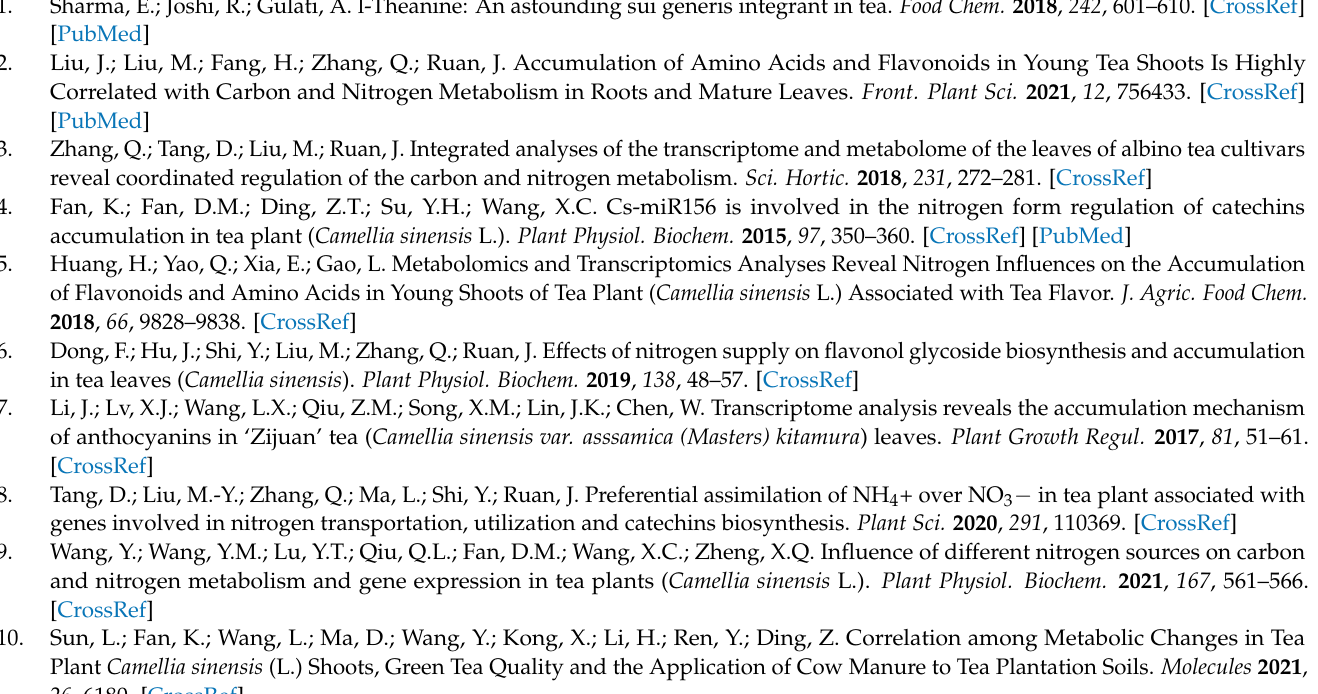
amino acid determination; Table S2: UPLC-MS/MS parameters for flavonoid determination; Table S3: UPLC-MS/MS parameters for phytohormone determination; Table S4: The correlation between phytohormones and amino acids; Table S5: The correlations between phytohormones and phenolic compounds; Table S6: The correlations between phenolic compounds and amino acids; Table S7: The correlations among components of amino acids; Table S8: The correlations among components of phenolic compounds; Table S9: The correlations among components of